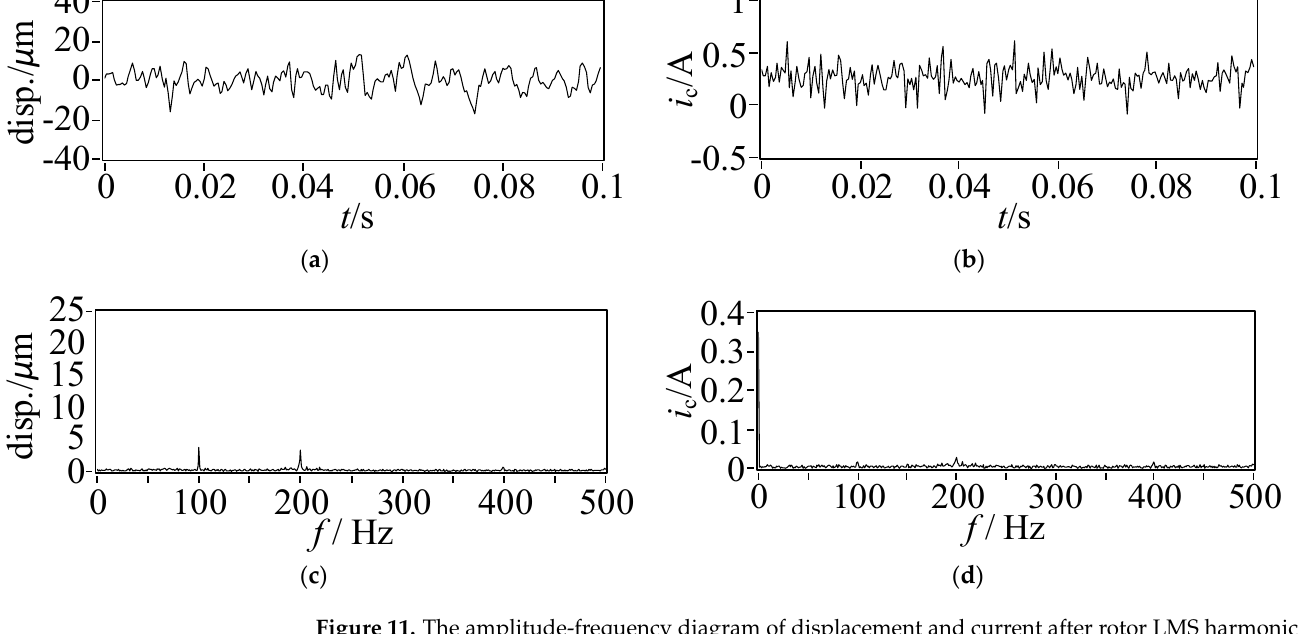
Figure 11. The amplitude-frequency diagram of displacement and current after rotor LMS harmonic compensation. ( a ) Time domain spectrum of displacement; ( b ) Time domain spectrum of current; ( c ) Frequency spectrum of displacement; ( d ) Frequency spectrum of current. The data with a time of 1 s were randomly taken, and the peak-to-peak mean was